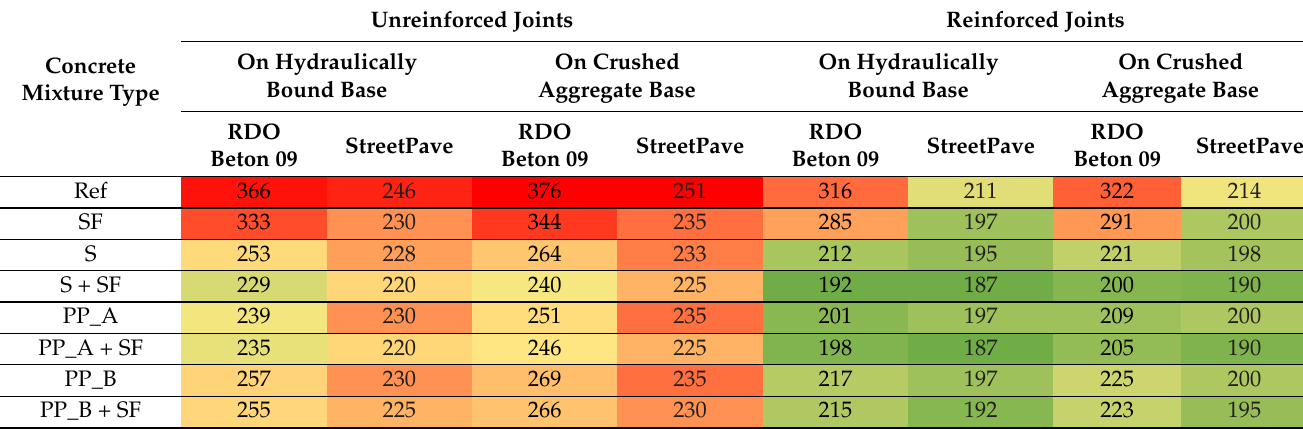
Table 6. Calculated thickness of PCP according to RDO Beton 09 and design program StreetPave.